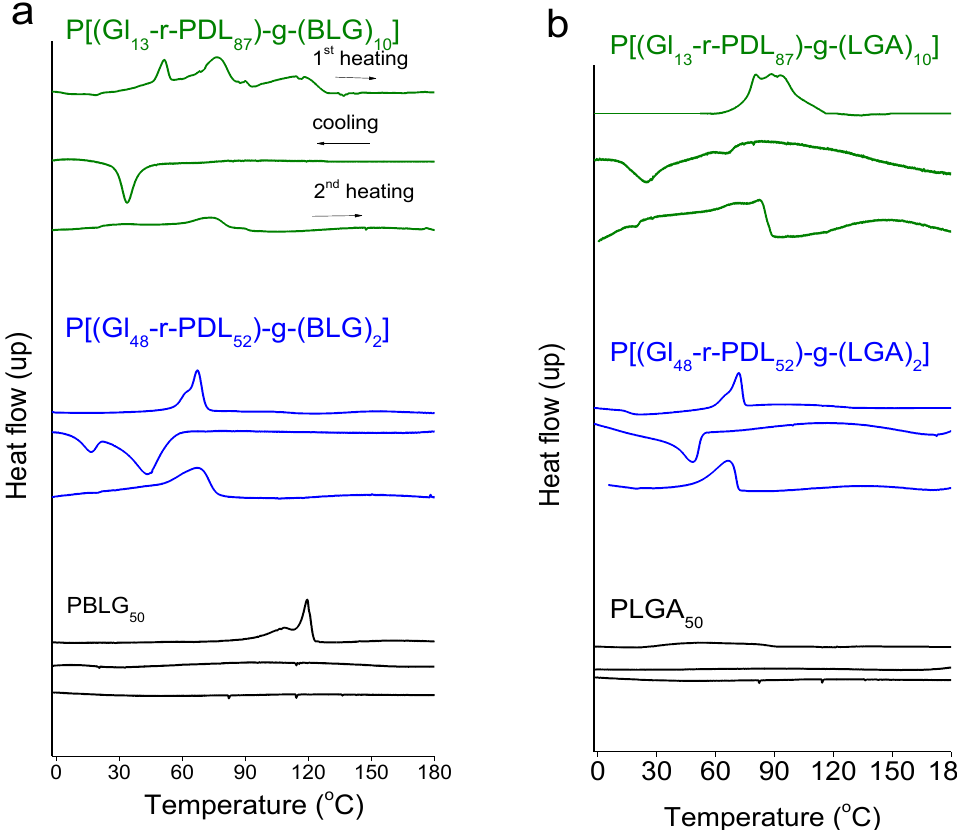
Figure 4. Heating and cooling DSC traces of P[(Gl x - r -PDL y ) – g – (LGlu) z ] copolymers.